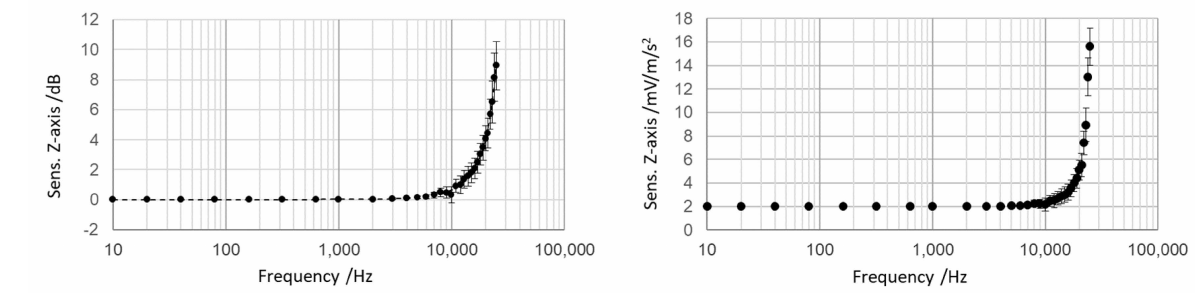
Figure 7. Sensitivity expressed in mV/ms − 2 and in dB of the individual sensing element.